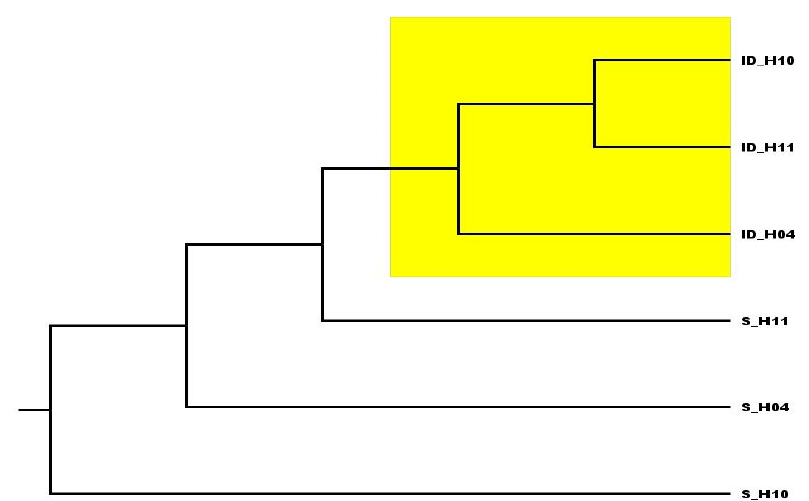
Figure 2. Dendrogram constructed with UPGMA method and Nei ’ s genetic identity [37] of the six S. cerevisiae grape populations of the ZARM region analyzed. Cophenetic Correlation Coefficient (CP) = 0.9910. Populations from ID vineyard are highlighted.